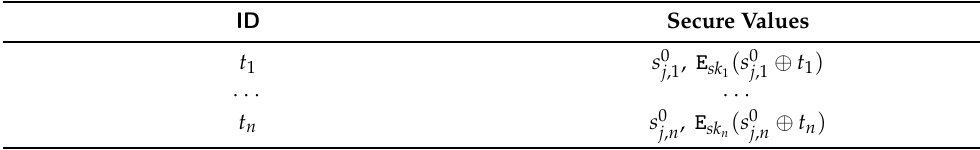
Table 3. Access List L j for a Mobile